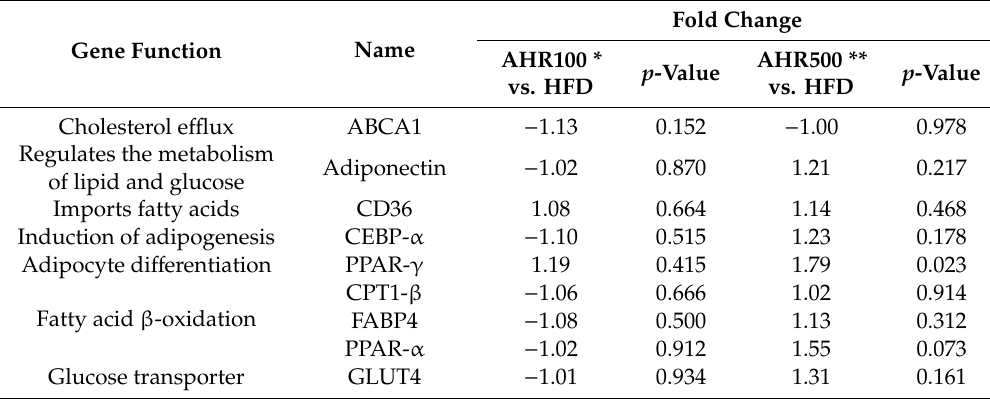
HFD-induced obese